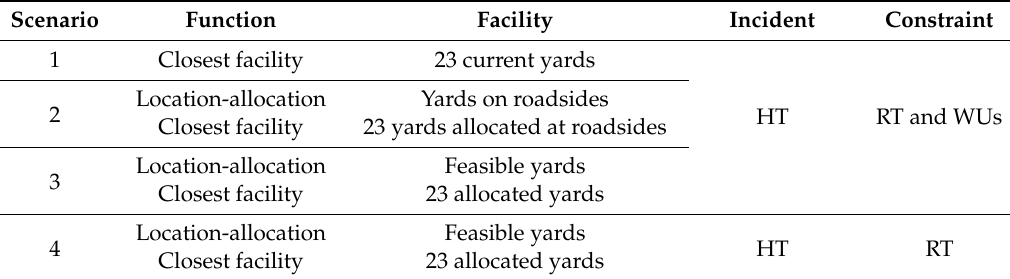
Table 2. Setting up the network optimization in the Network Analyst tool.